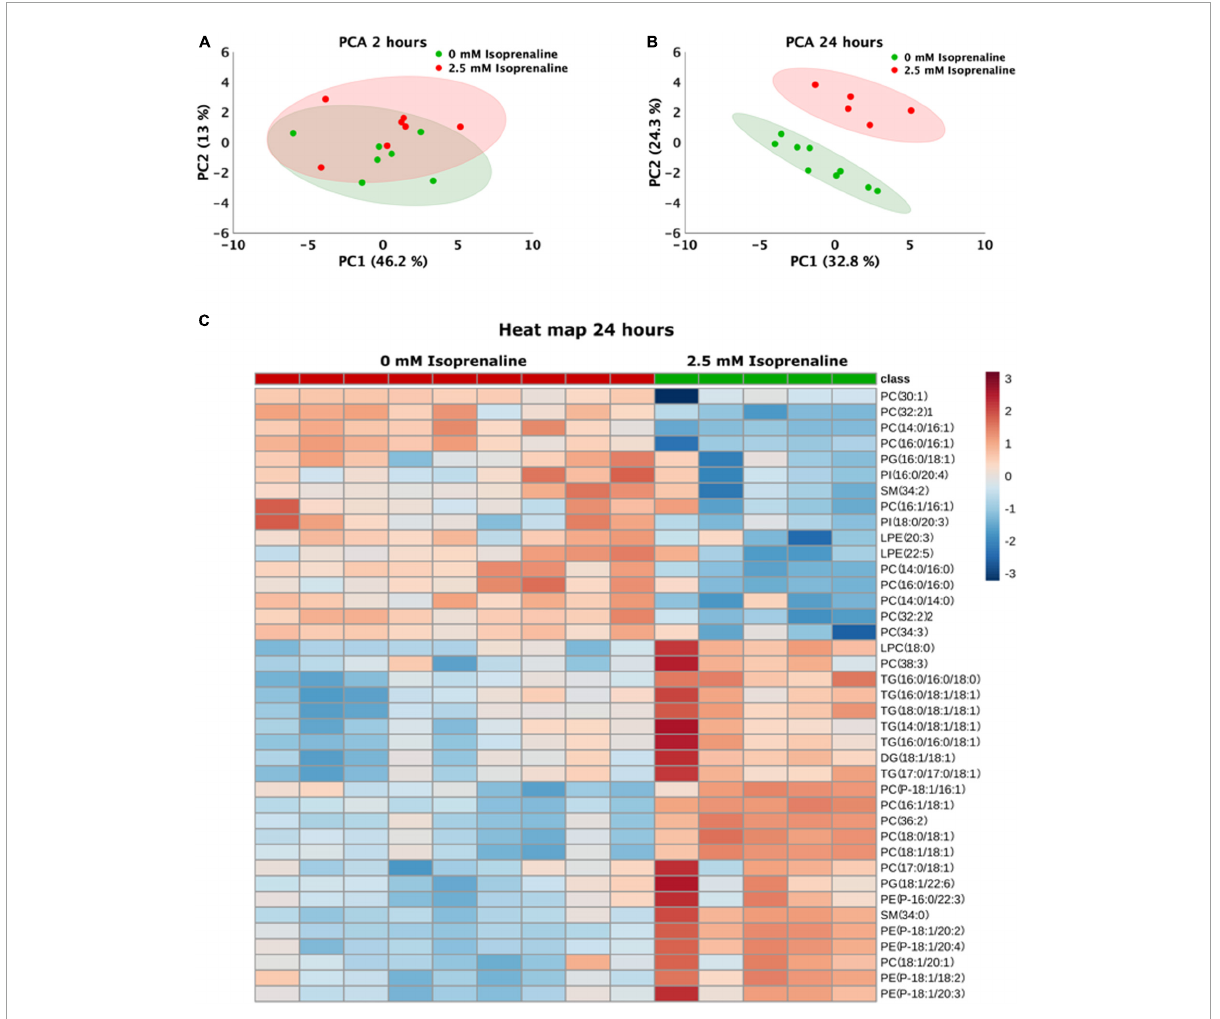
FIGURE4 Changes in the lipidomics profile induced by high-level and long-term exposure to isoprenaline. (A,B) Principal Component Analyses showed that prolonged exposure of HL-1 cardiomyocytes to 2.5 mM of isoprenaline promotes a distinct shift of the lipidomic profile compared to 2 h of exposure. (C) Clustering result of statistically significant molecules of lipids in the HL-1 cardiomyocytes exposed to 2.5 mM of isoprenaline for 24 h. n = 5–9 biological replicates per group, one technical